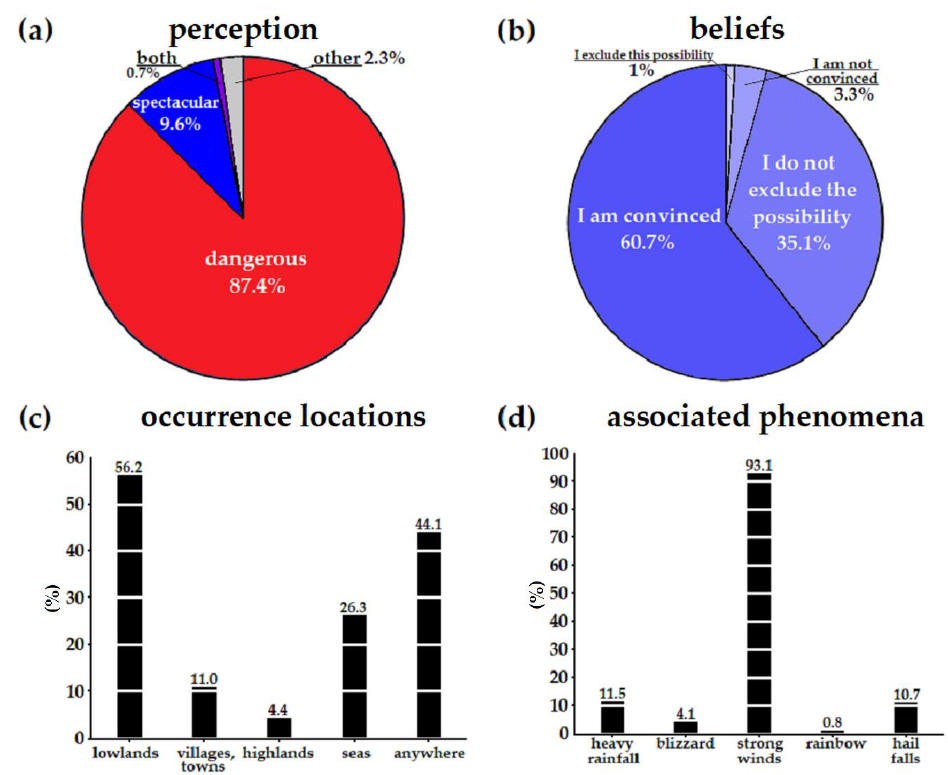
Figure A1. The summary results of questions Q2 to Q5 regarding: the respondents’ perceptions of tornadoes ( a ), their beliefs ( b ), their knowledge of tornado occurrence locations ( c ) and the most dangerous associated phenomena ( d ).